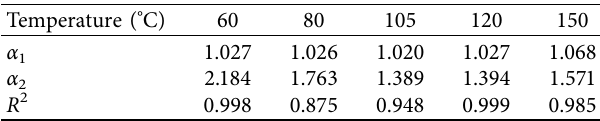
Table 5: Temperature parameters at different drying temperatures and R 2